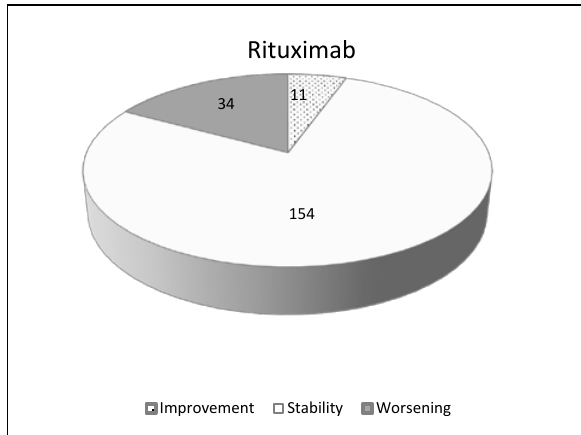
Figure 4. Pulmonary effects of rituximab in RA-ILD patients: a review of the literature.